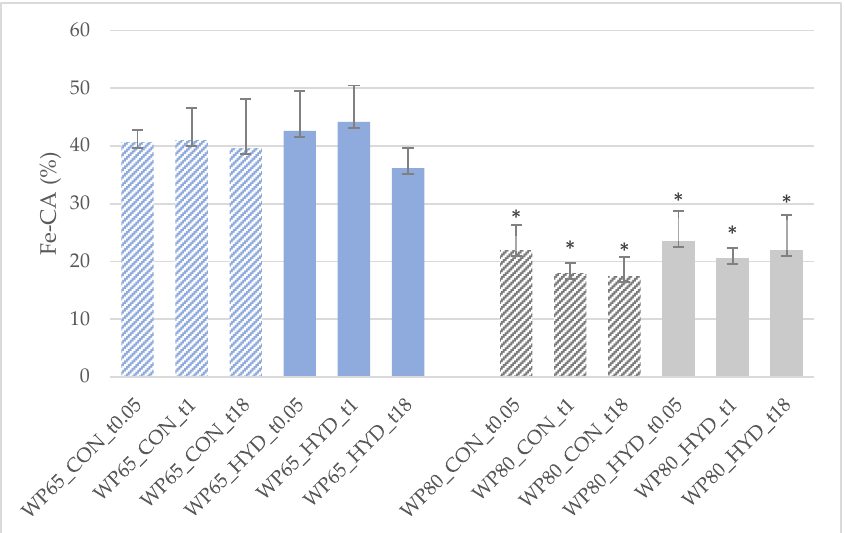
Figure 4. % Fe 2+ chelating activity (Fe-CA) after a 30 min reaction of the tryptic hydrolysates of 5% ( w / w ) solutions of WPC powders of sheep/goat origin manufactured from Feta cheese whey in comparison to non-treated counterparts. 1 Abbreviations explained in Table 1 and Section 2.2.3. Means and standard deviations of three experiments. * Statistically significant differences ( p < 0.05) between WP80 and WP65 counterparts.